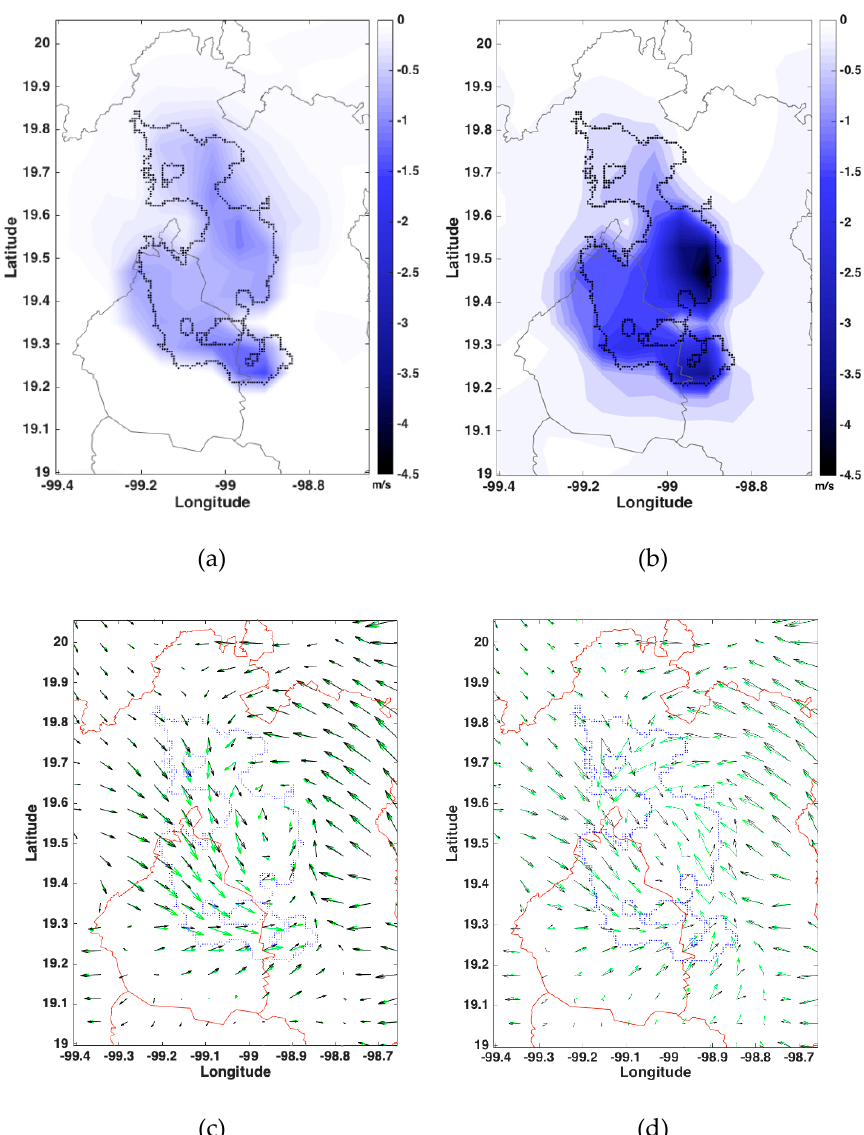
Figure 5. Difference between No-Lake and Lake simulations results of the wind speed at 2 m above the water surface with the uncoupled WRF ( a ) and the coupled WRF ( b ) models. Wind directions obtained with No-Lake (black arrows) and Lake (green arrows) simulations using the uncoupled WRF ( c ) and coupled WRF ( d ) models. The time in both simulations is 3:00 UTC.